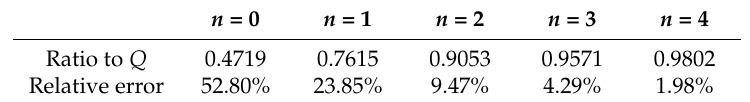
Table 1. Relative error of the first five items of the thermal function expansion. Q is the heat source. n = 0 n = 1 n = 2 n = 3 n = 4 Ratio to 𝑄 0.4719 0.7615 0.9053 1.98%